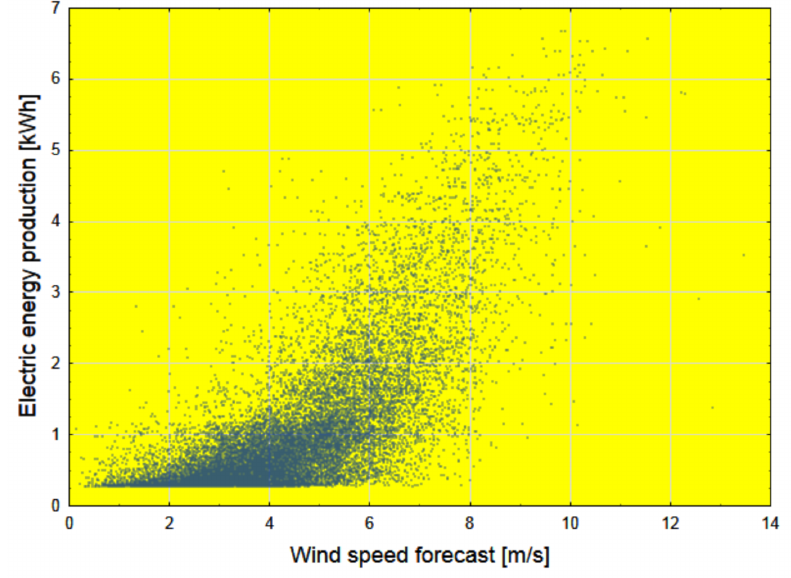
Figure 6. Relationship between wind speed forecasts [p.u.] and actual electricity production. Eight different sets of input data with different information potential were proposed for the forecasts in order to analyze differences in the quality of forecasts between the sets. Table 4 presents sets of appropriate, selected sets of input data for the forecasting methods described in Section 3. Global sensitive analysis in the MLP model was used to eliminate unnecessary input data in the given set (from set 4 to set